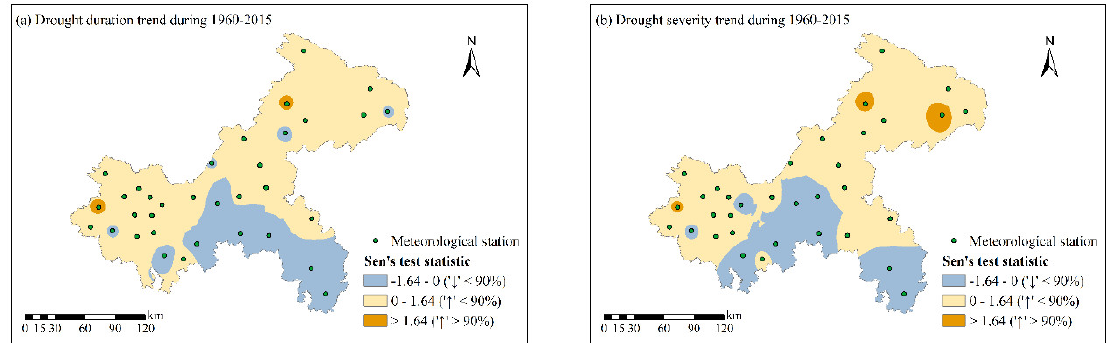
Figure 11. Spatial trend evolution of annual drought duration ( a ) and drought severity ( b ) of extreme drought events from 1960 to 2015.